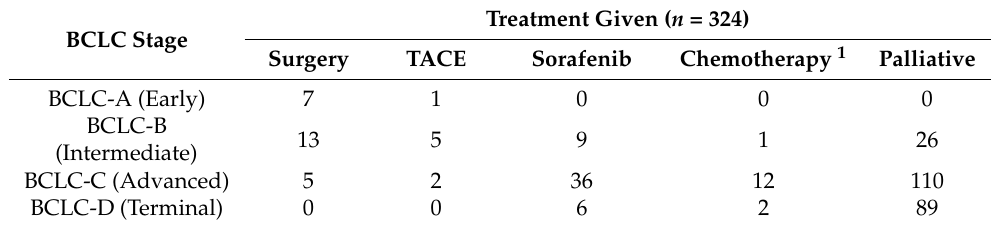
Table 3. Types of treatment given to HCC patients with respect to the BCLC stages of